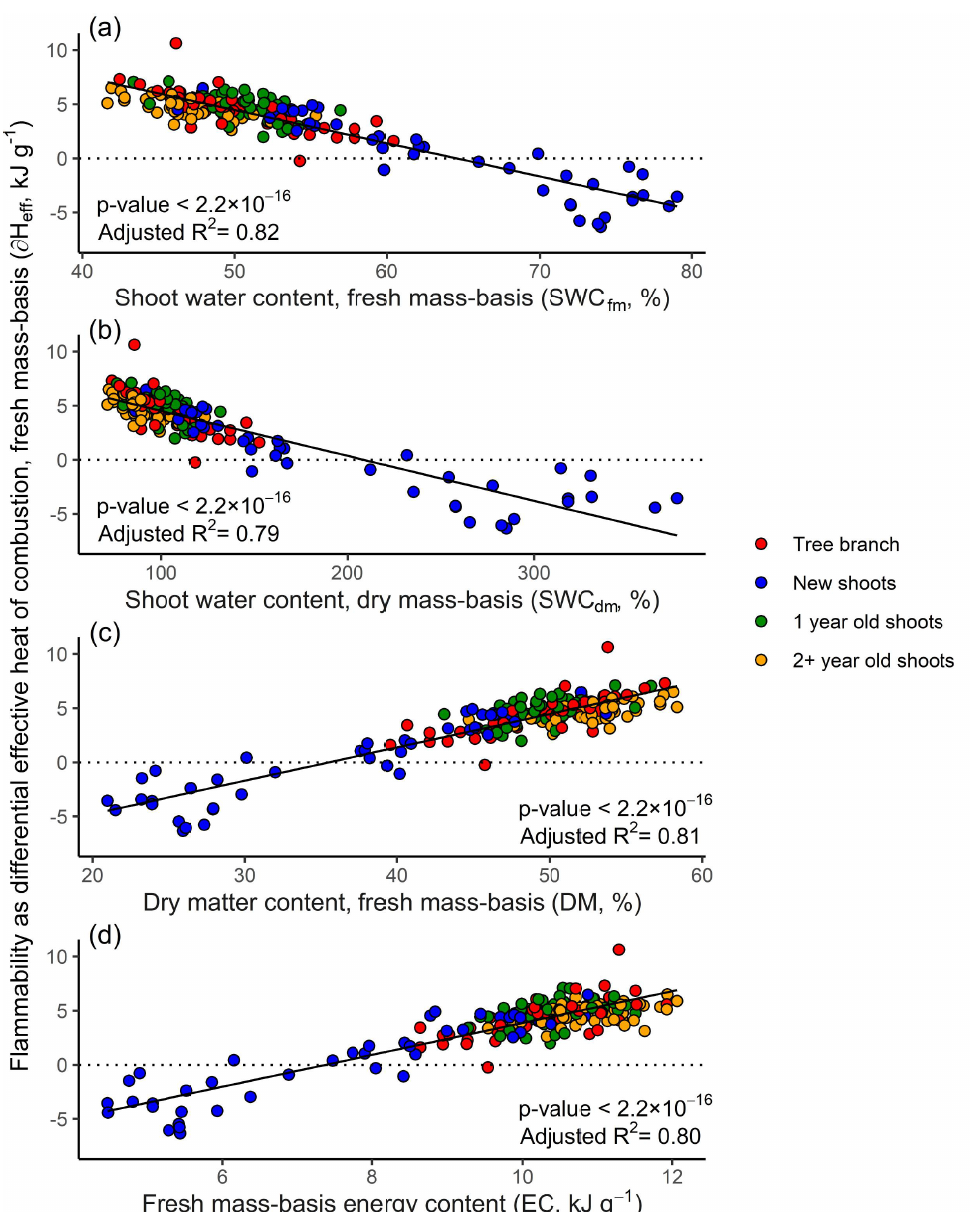
Figure 8. Factors affecting live fuel flammability. Flammability as differential effective heat of combustion on a fresh mass basis ( ∂ H eff ) for tree branch, new, 1 year-, and 2+ year-old shoots of white spruce in relation to ( a ) shoot water content on a fresh mass basis (SWC fm ), ( b ) shoot water content on a dry mass basis (SWC dm ) as analog of FMC, ( c ) dry matter content, (DM), and ( d ) fresh mass basis energy content (EC). Red, blue, green, and orange dots represent tree branch, new, 1 year-, and 2+ year-old shoots,